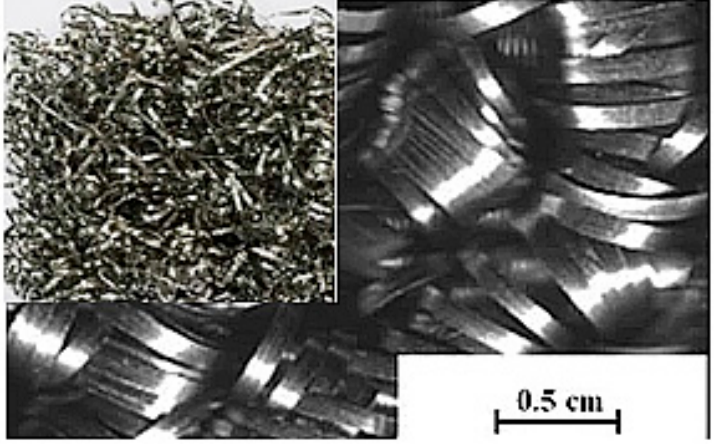
Figure 3. An example of stainless steel wool